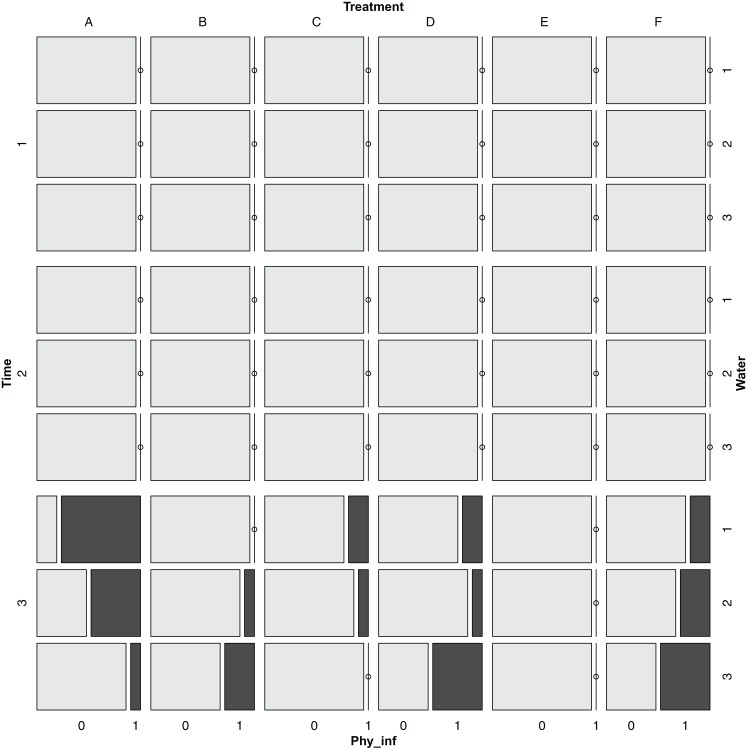
Mosaic plot for the presence of Phytophthora infestans for different times, treatments and watering regimes.Time dates (m/d) were T1: 4/14; T2: 5/3; T3: 6/1. Treatments are noted as (A) recommended Urtica dose; (B) half the recommended dose; (C) double the recommended dose; (D) Urtica recommended dose in combination with Equisetum; (E) Conventional foliar manure; (F) control. Watering regimes were 1: blocks 1 and 2; 2: blocks 3 and 4; 3: blocks 5 and 6.